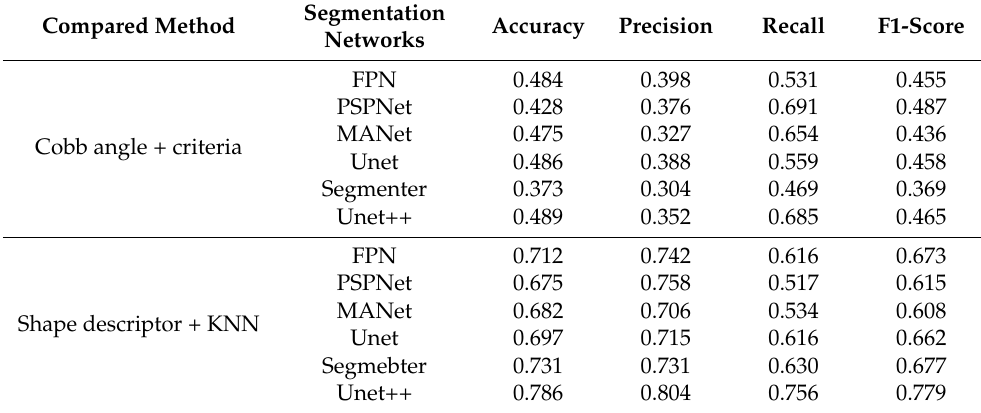
Table 7. Results of the classification framework based on Cobb angle measurement and shape description. Compared Method